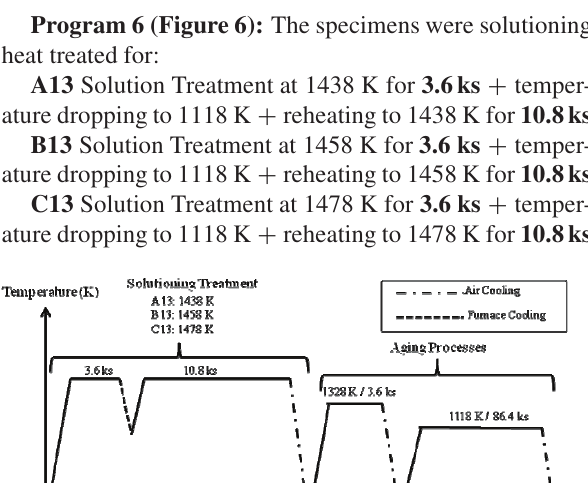
Figure 5. Simulated reheat treatment programs: A4, B4 and C4.